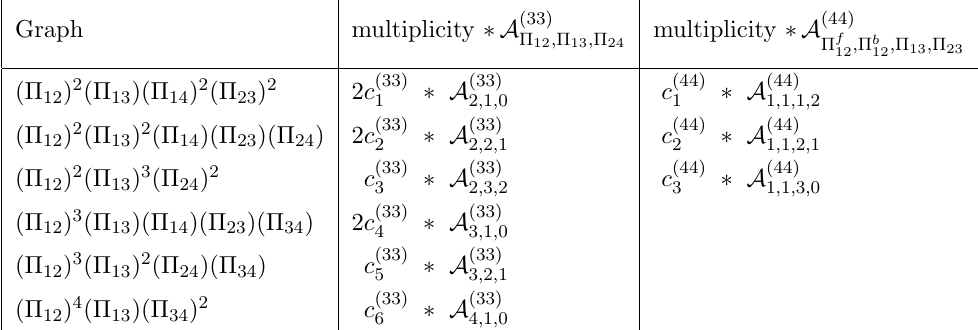
Relevant graphs and the corresponding hexagon amplitudes for the correlator hB 5 B 4 O 3 O 2 i . The graphs’ topologies are grouped according to (cid:12)gure 3. Notice that one choice of propagators (cid:5) ij can be embedded in multiple topologies depending on how the progagators are distributed among the front and back of the sphere. For instance, in the (cid:12)rst line, we can write ((cid:5) 12 ) 2 ((cid:5) 13 )((cid:5) 14 ) 2 ((cid:5) 23 ) 2 in two ways on topology (33) when the two (cid:5) 12 -propagators are both on the front or both on the back of the sphere | hence the factor of two. When one is on the front and one is on the back, we have a single graph of topology